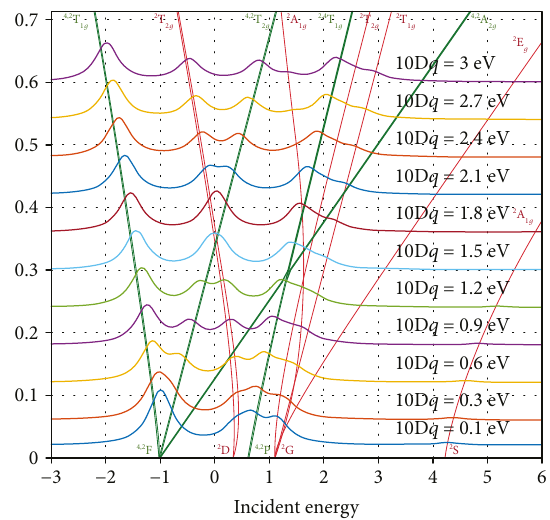
Figure 21: In fl uence of the O crystal fi eld on the 1s XAS projection h of the calculated 1s2p RIXS spectra for Ti 3+ ( 3d 1 ) with ELD overlay. A comparison to the calculated 1s XAS projections now shows on the one hand that neglecting 3d SOC in this step is a valid approximation. And on the other hand, it con fi rms that a quadrupole transition from the 2 T ground state symmetry can 2 g reach A , E , T , and T symmetries, but the A symmetry does 1 g 1 g 2 g 2 g g apparently not contribute to the